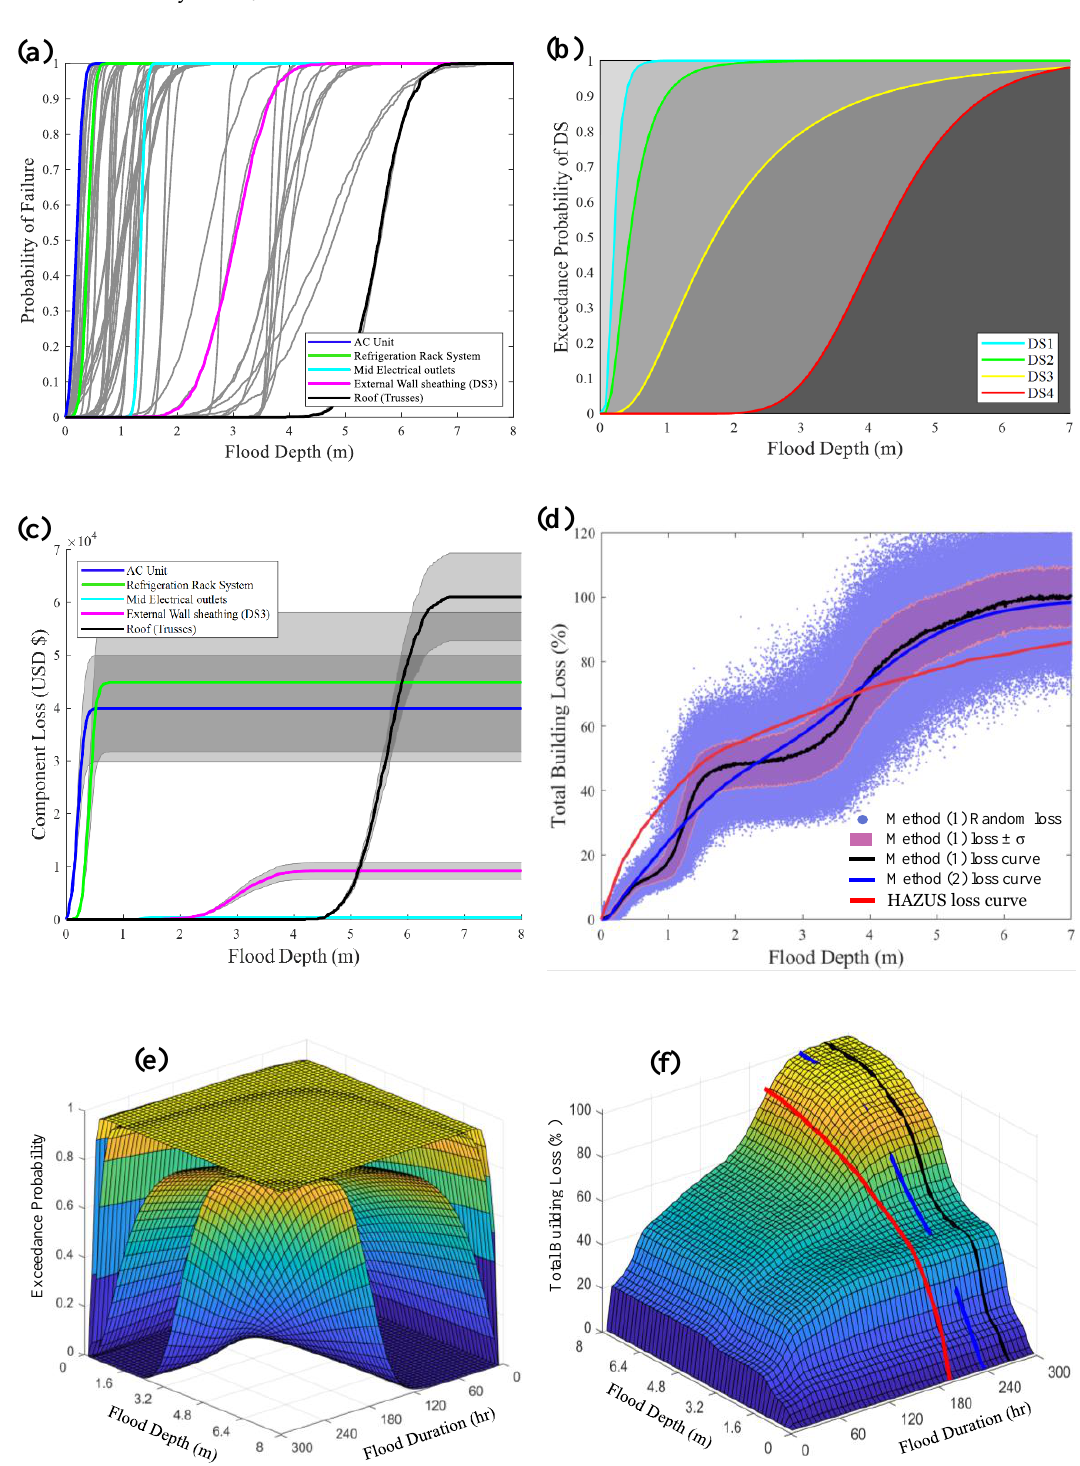
Figure A19. F5 archetype analysis results: ( a ) Component fragility curves; ( b ) Building fragility curves; ( c ) Selected components’ loss curves; ( d ) Building loss curves; ( e ) Building fragility surfaces; ( f ) Building loss surface.